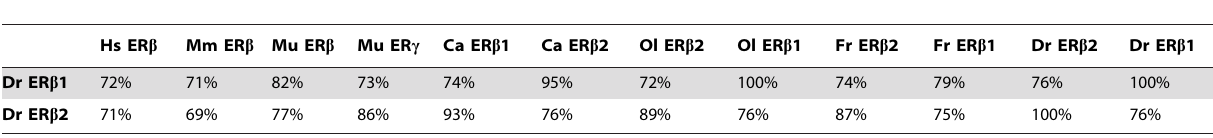
Table 1. Amino acid conservation in the ERbeta ligand binding domains.